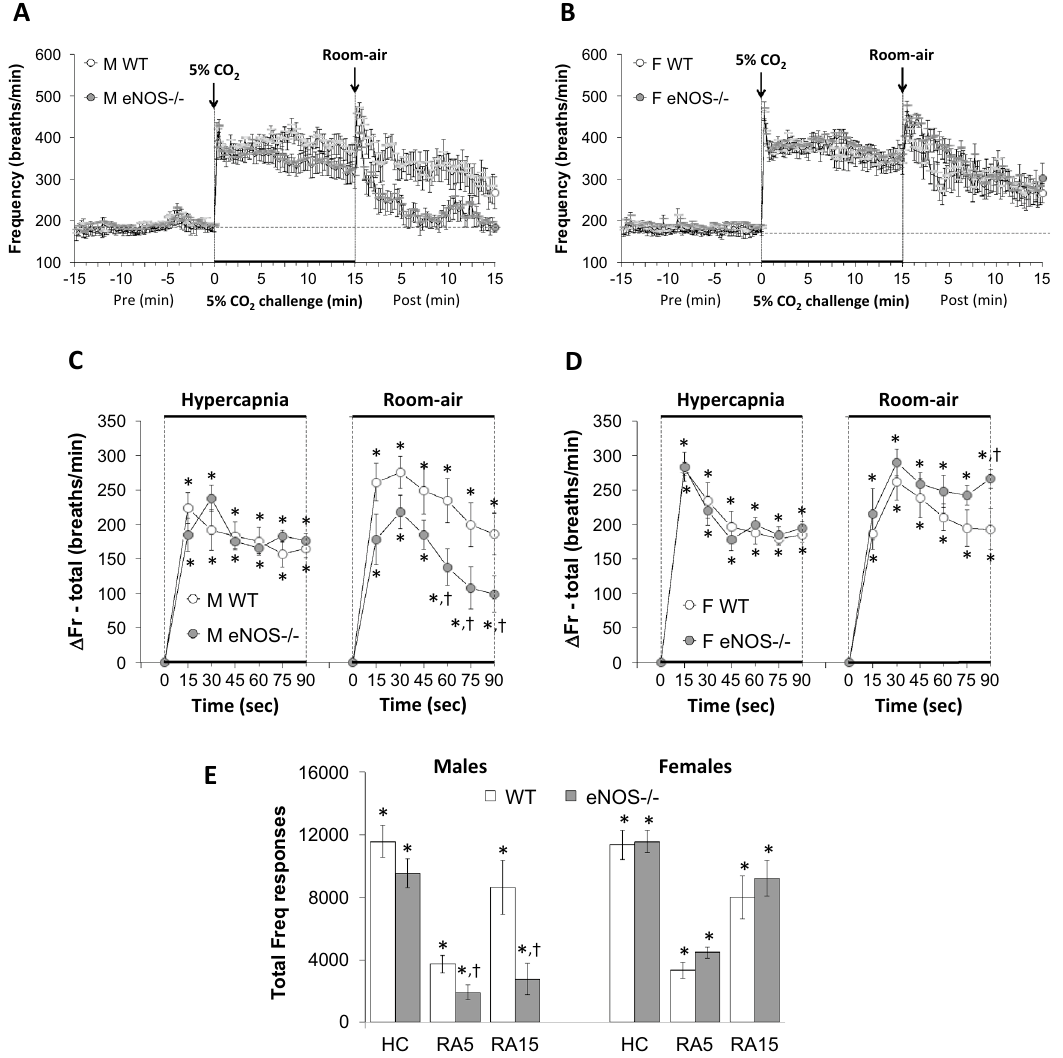
Figure 1. Panels ( A ) and ( B ) Frequency of breathing (Freq) values before, during a hypercapnic (HC) gas challenge (5% CO 2 , 21% O 2 , 74% N 2 ) and upon return to room-air in male (M) and female (F) wild-type (WT) and eNOS knock-out (eNOS-/-) mice. Panels ( C ) and ( D ) Arithmetic changes in Freq in male and female WT and eNOS-/- mice during the first 90 s of exposure to HC challenge and the first 90 s upon return to room-air. Panel ( E ) Total changes in Freq in male and female WT and eNOS-/- mice during HC challenge and during the first 5 min (RA5) and entire 15 min (RA15) return to room-air. The data are presented as mean ± SEM. * P < 0.05, significant change from pre-values. † P < 0.05, eNOS-/- versus WT within each